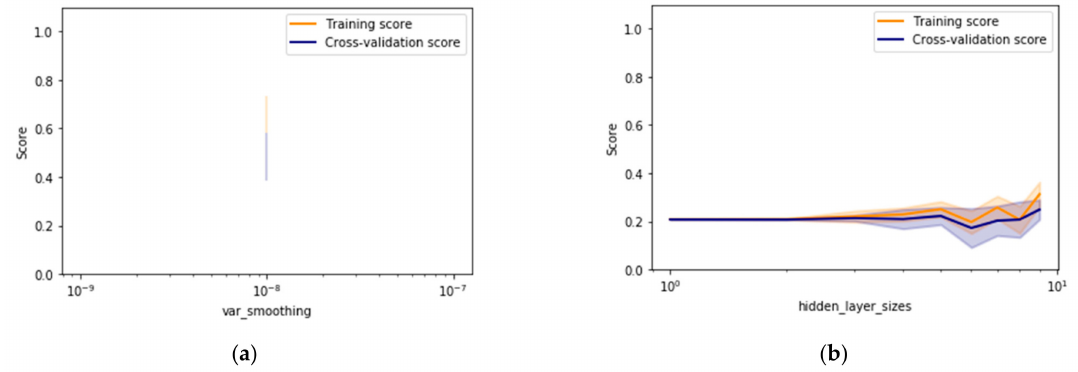
Figure 7. Validation curves generated for NBC and MLP ( a ) NBC Smoothing parameter and ( b ) MLP number of hidden layers.